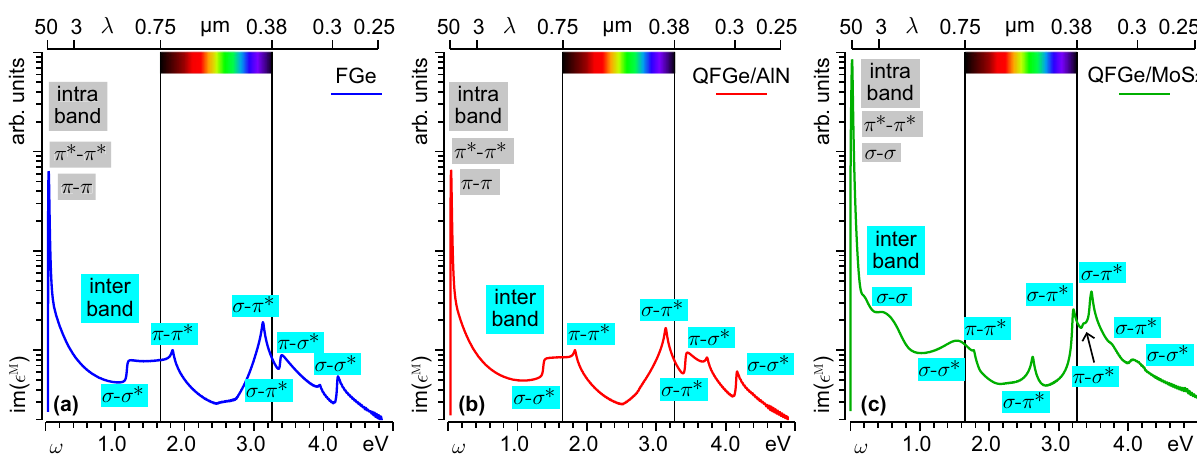
M , labeled as in